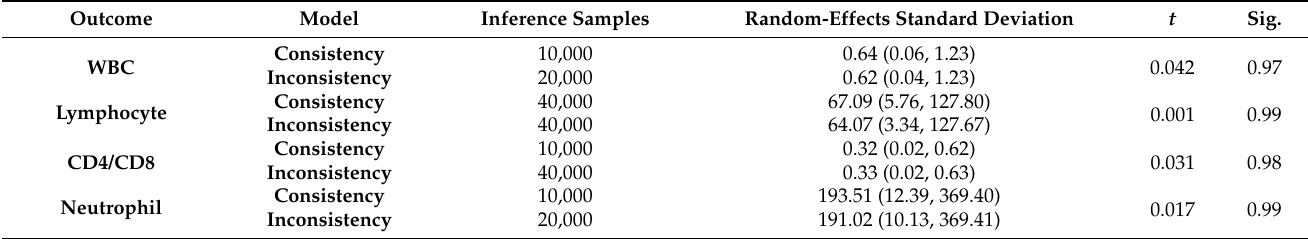
Table 5. The results of the random-effects standard deviation